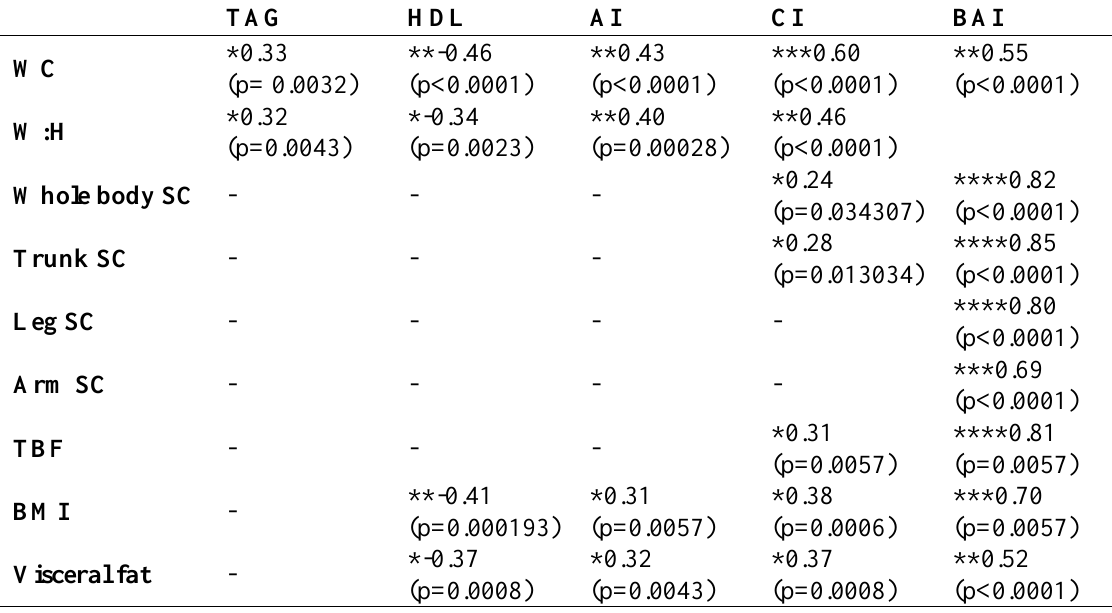
Table 6: Correlations between anthropometric parameters and lipid